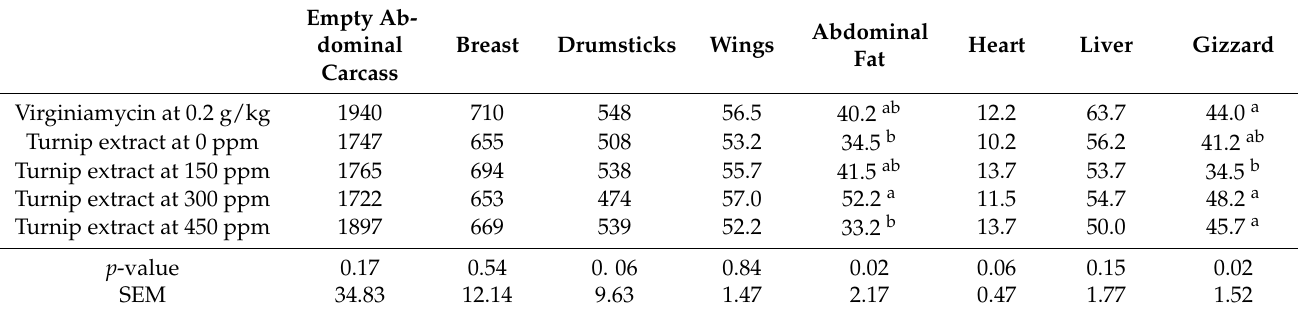
Table 3. Mean ± SEM of carcass and organs weights of Ross broilers at d 42 when supplemented with different levels of Brassica rapa extract at 0–450 ppm or Virginiamycin from weeks 1–6